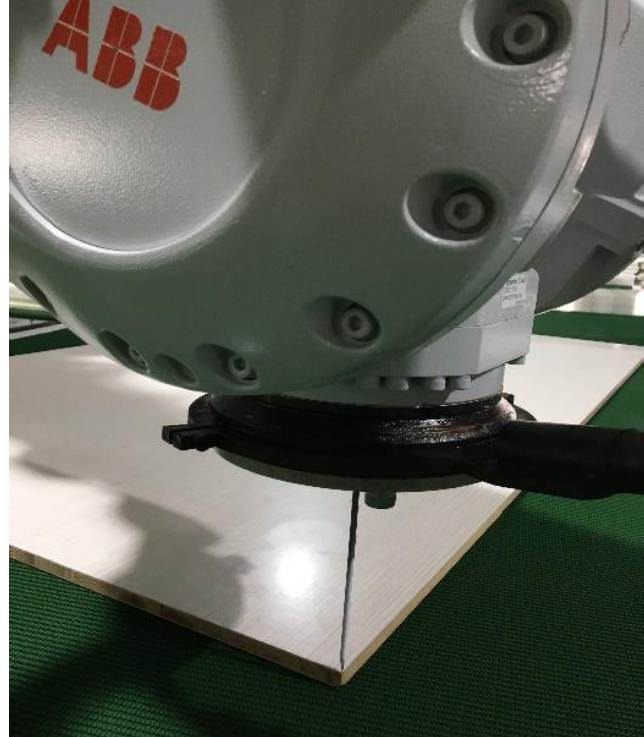
Figure 9. Four-point calibration method. Table 3. Four-point calibration